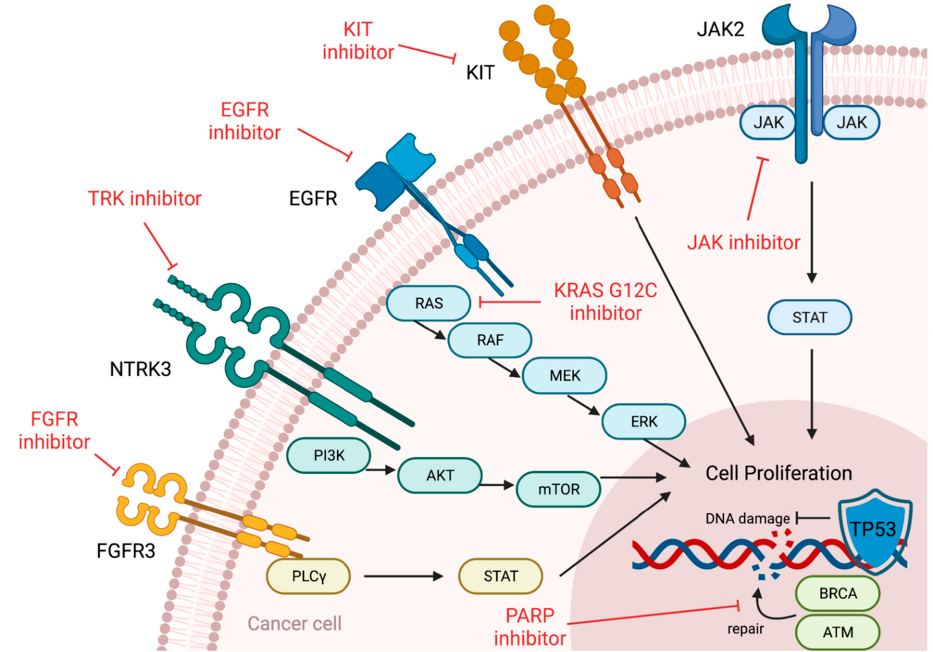
Figure 2. Schematic drawing of cell proliferation. JAK2, KIT, EGFR, NTRK3 and FGFR3 proteins are tyrosine kinase receptors. KRAS proteins transduce receptor signaling into cellular processes. These proteins activate the signaling pathways such as PI3K/AKT/mTOR and RAS/RAF/MEK/ERK pathways. BRCA and ATM have an important role in repairing damaged DNA. Molecular-targeted drugs suppress these proteins overexpressed by gene mutations. TP53 maintains the harmony between cell arrest and growth during genomic stress.